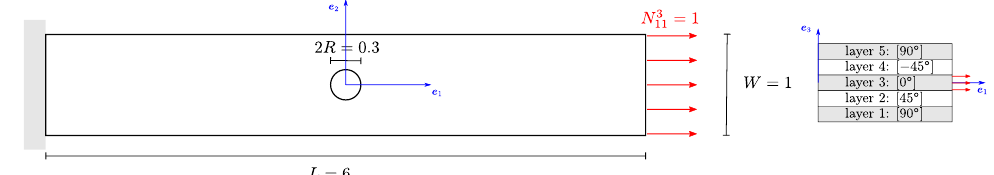
Figure 9. Laminate with circular hole under